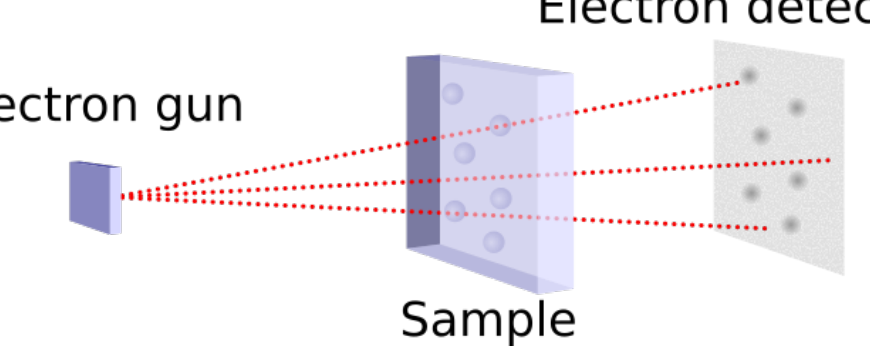
Figure 1. Principle of the TEM.